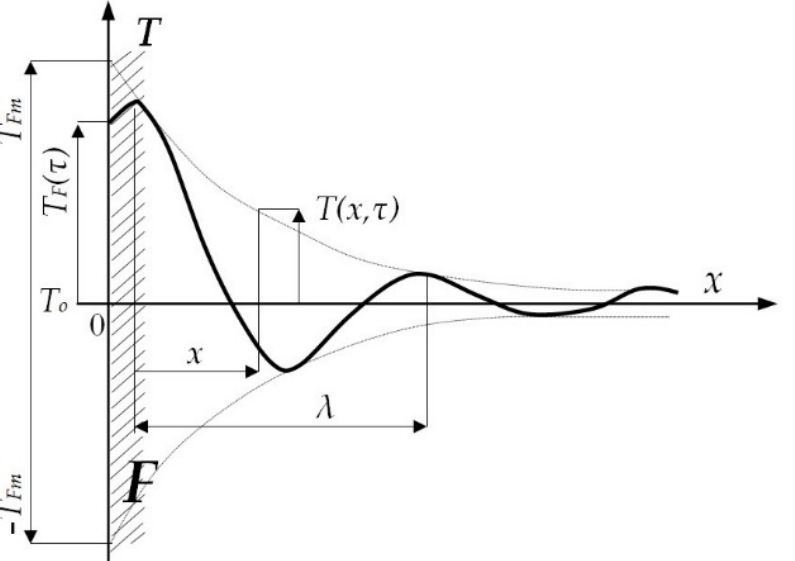
Figure 1. Temperature change T ( x , τ ) in a semi-infinite body along the x -axis when changing the external surface temperature F according to the cosine function-case for a selected time instant τ .